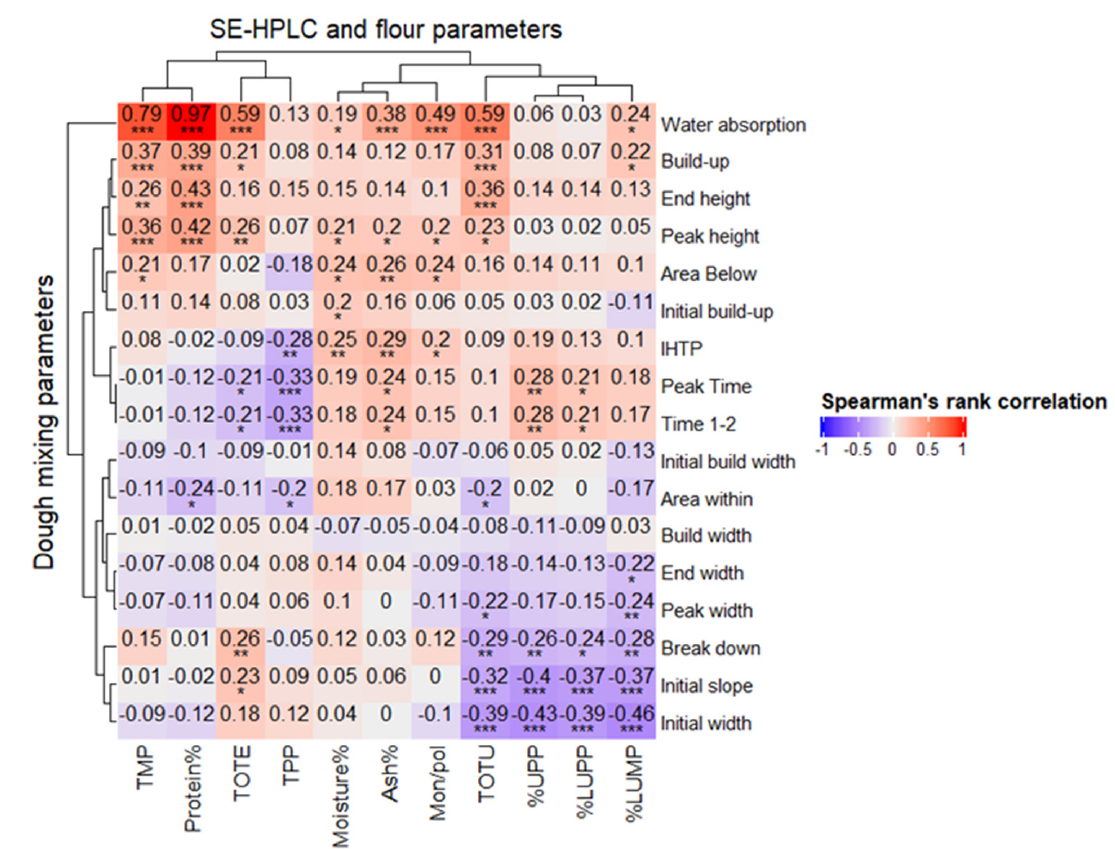
Figure 3. Spearman’s rank correlation matrix and hierarchical clustering of results (dendogram) based on complete linkage method for the gluten protein parameters obtained by SE-HPLC; flour protein (%), moisture (%), and ash (%) determined by NIT (taken from Lama et al. 2022) and 17 dough mixing parameters of 56 spring wheat genotypes grown in cool (2017) and heat–drought (2018) years. ***, **, and * indicate significance at p < 0.001, p < 0.01, and p < 0.05.